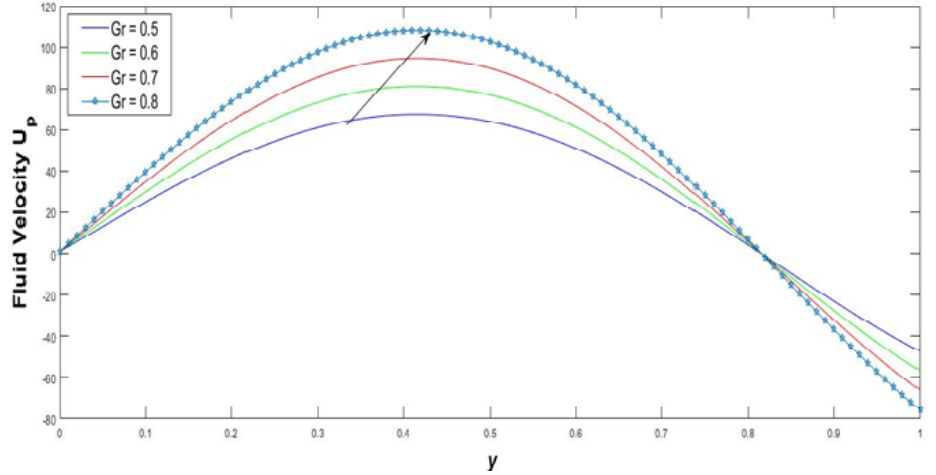
Figure 8. Velocity field for various Grashof numbers.